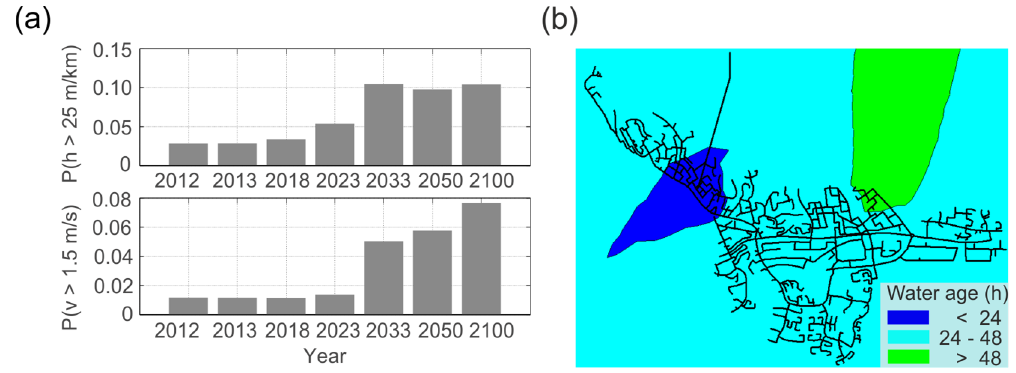
Figure 11. ( a ) Threshold exceedances of unit head loss (top) and velocity (bottom) at peak load for scenario “Growth”, ( b ) WDS with maximum water age for scenario “Baseline” at transition stage